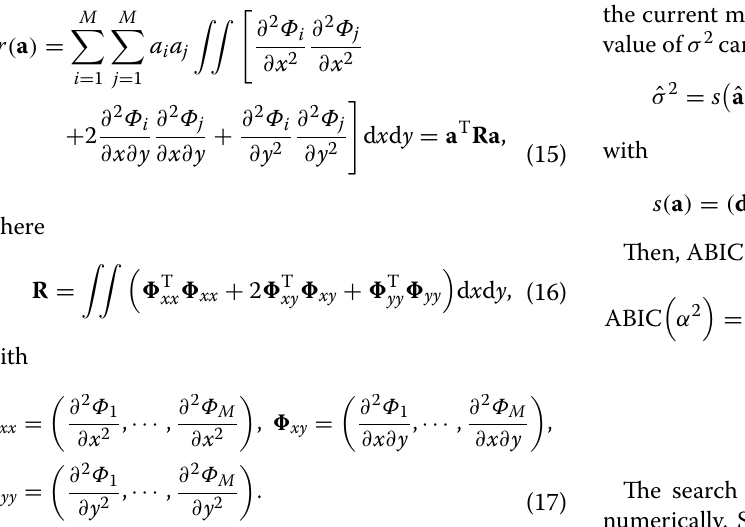
duce prior constraints on the smoothness of a velocity field in the form of the degenerate Gaussian